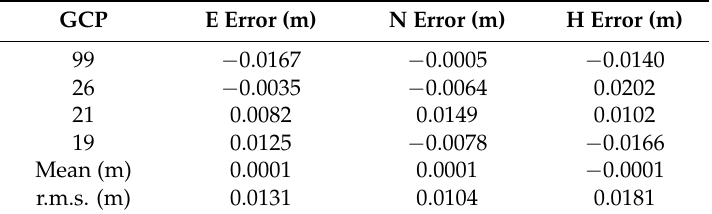
Table 3. Photoscan Georeferencing